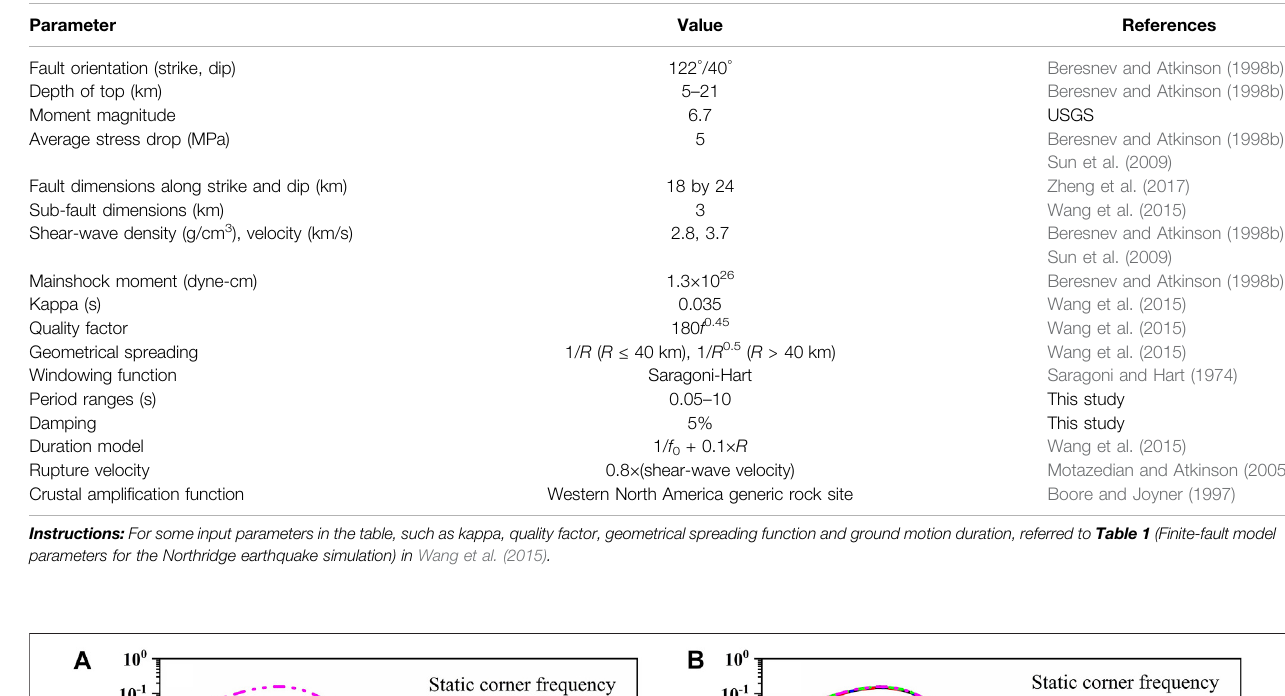
TABLE 5 | Input parameters for the simulation of the Northridge earthquake.